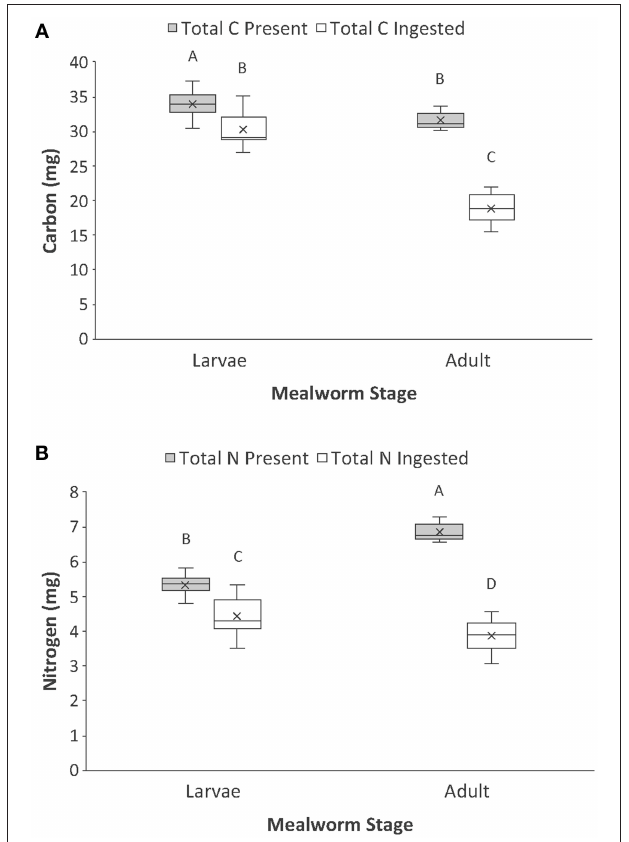
FIGURE 3 | Comparison of the (A) lipid and (B) protein present vs. ingested by spiders when feeding on larval and adult mealworm beetles. Boxplots display the interquartile range (the box), median (line in the box), mean (x in the box), minimum (lower whisker), maximum (upper whisker), and any outliers (additional points). Treatments with different letters are significantly different from each other in post hoc